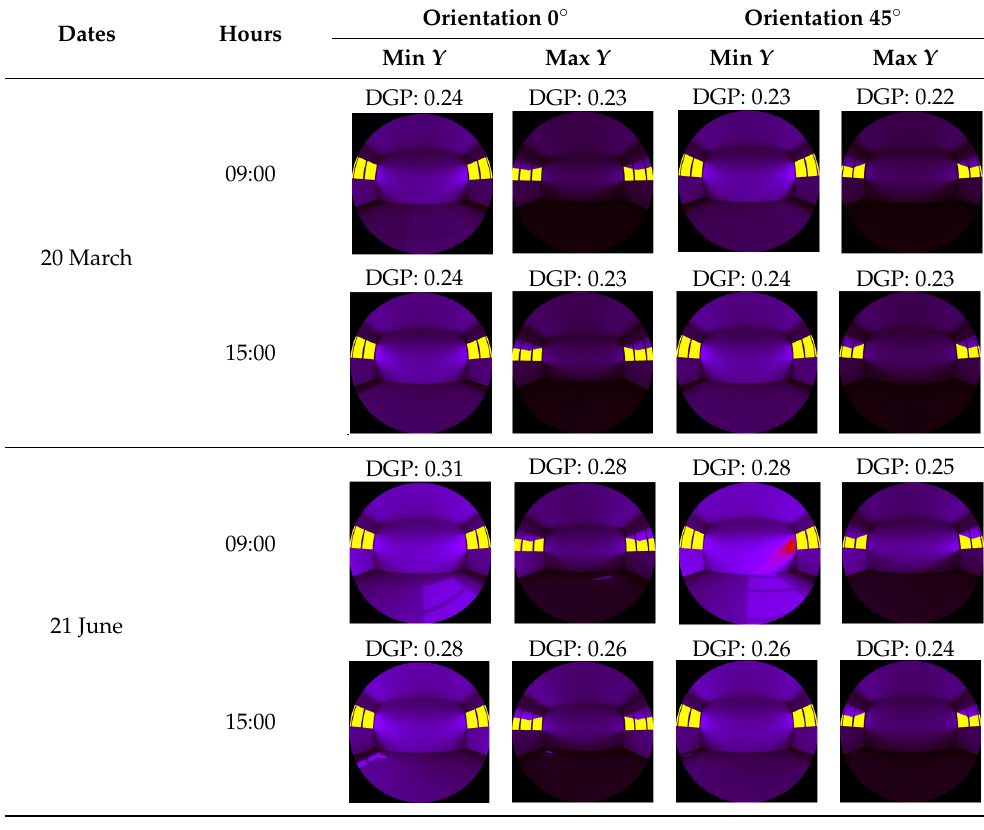
Table 4. DGP values at orientations of 0 ◦ and 45 ◦ at 09:00 and 15:00 h on 20 March, 21 June, and 21 December *.